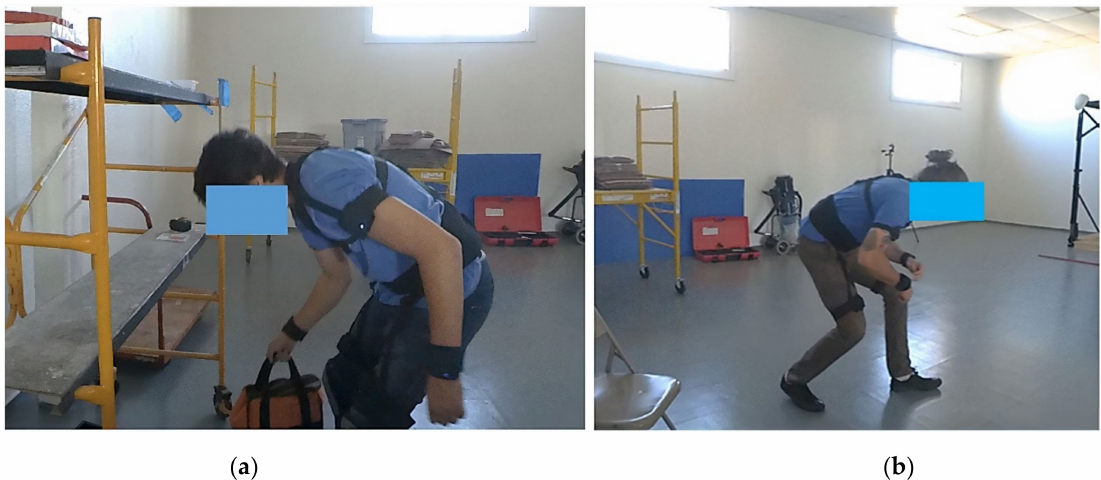
Figure 7. Activities with similar trunk flexion have low prediction accuracies: ( a ) one-handed lifting, an asymmetrical activity (83%); ( b ) crouching